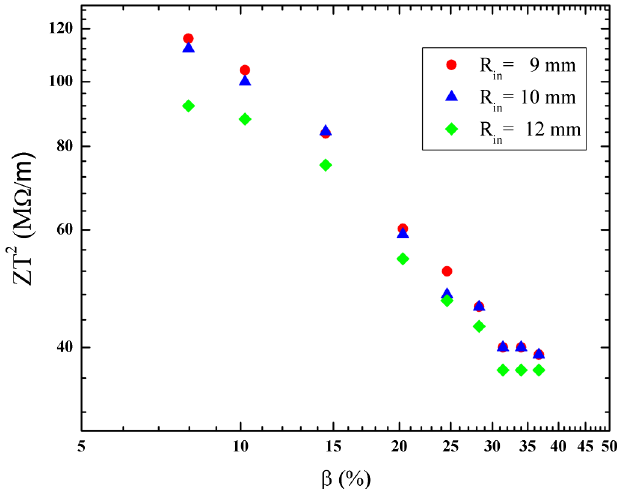
FIG. 5. Effective shunt impedance as a function of the velocity profile for drift tube apertures of 18, 20, and 24 mm at the resonance frequency of 325